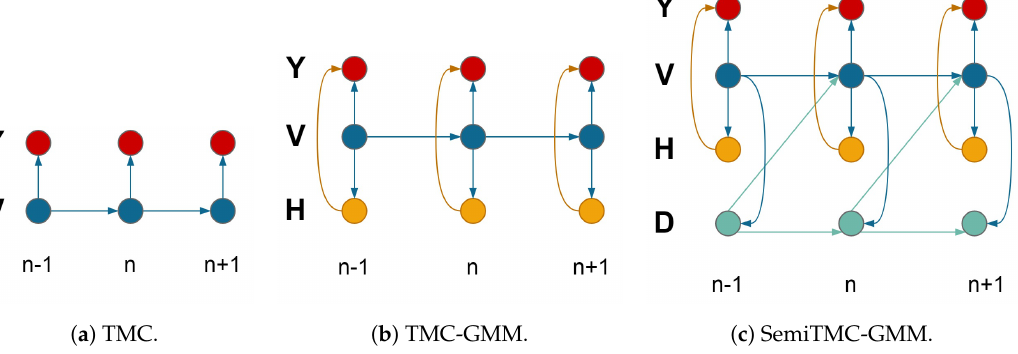
Figure 1. Dependency graphs. TMC = triplet Markov chain; GMM = Gaussian mixture